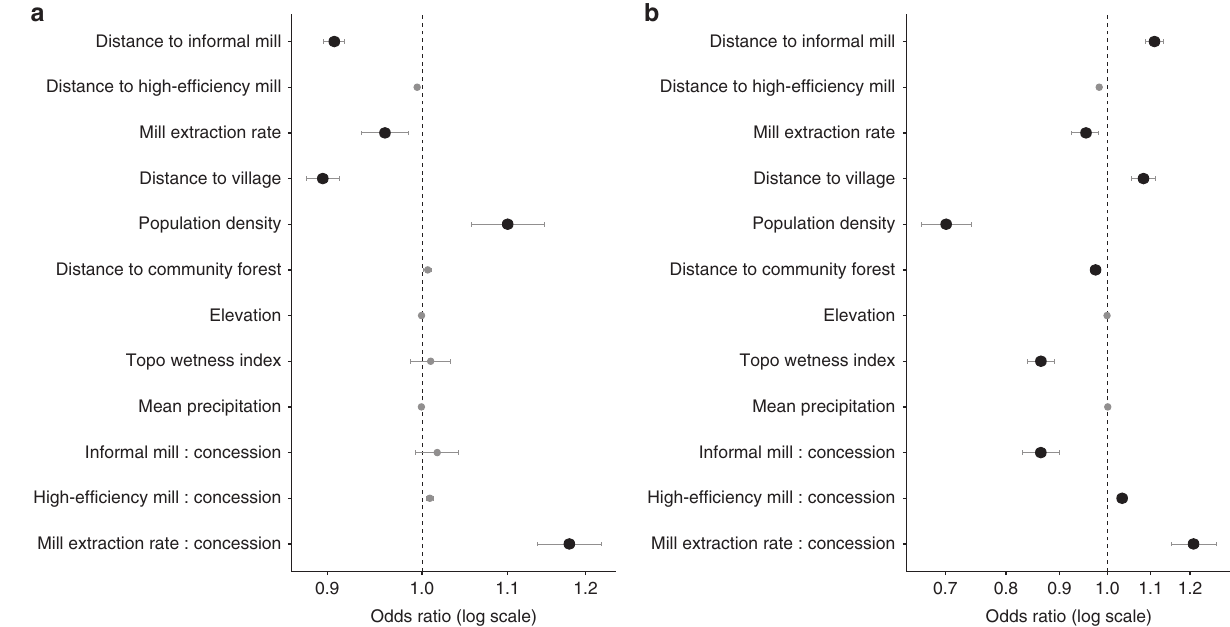
Fig. 4 Relative in fl uence of mills on expansion and deforestation. a , b Odds ratios from the binomial logit models predicting oil palm expansion ( a ) and deforestation due to oil palm expansion ( b ). Variables signi fi cantly affecting oil palm expansion ( a ) and deforestation ( b ) are indicated by the larger, black circles (signi fi cant at Wald test, p < 0.05 with odds ratios that do not overlap 1). Variables with odds ratios to the right of the dotted line at 1 indicate that an increase in that variable is associated with greater odds of oil palm expansion or deforestation, while odds ratios to the left of the dotted line indicate that an increase in that variable is associated with decreased odds. Bars correspond to the 95% con fi dence interval for odds ratios calculated using White – Huber standard errors from the oil palm expansion model ( n = 1,929,816) and deforestation model ( n =